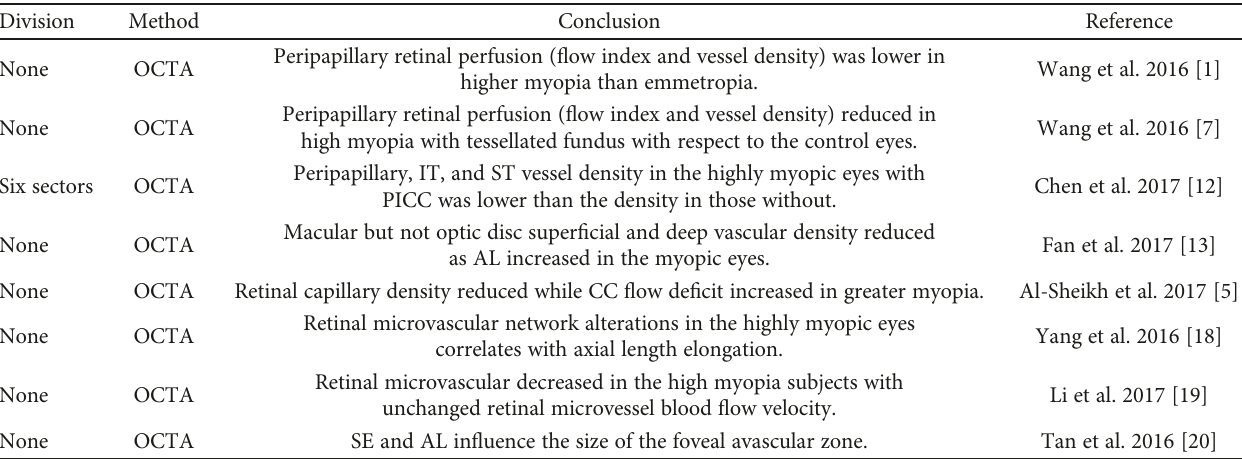
Table 5: Comparison of OCTA-based fundus vasculature studies in the myopic eyes. Division